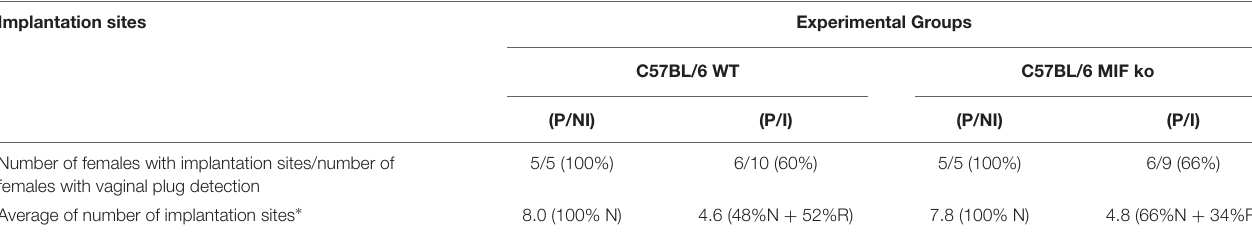
TABLE 1 | Pregnancy outcomes of C57BL/6 MIF − / − and WT mice orally infected with five cysts of T. gondii (ME-49 strain) on the first day of pregnancy (day of vaginal plug detection). Implantation sites